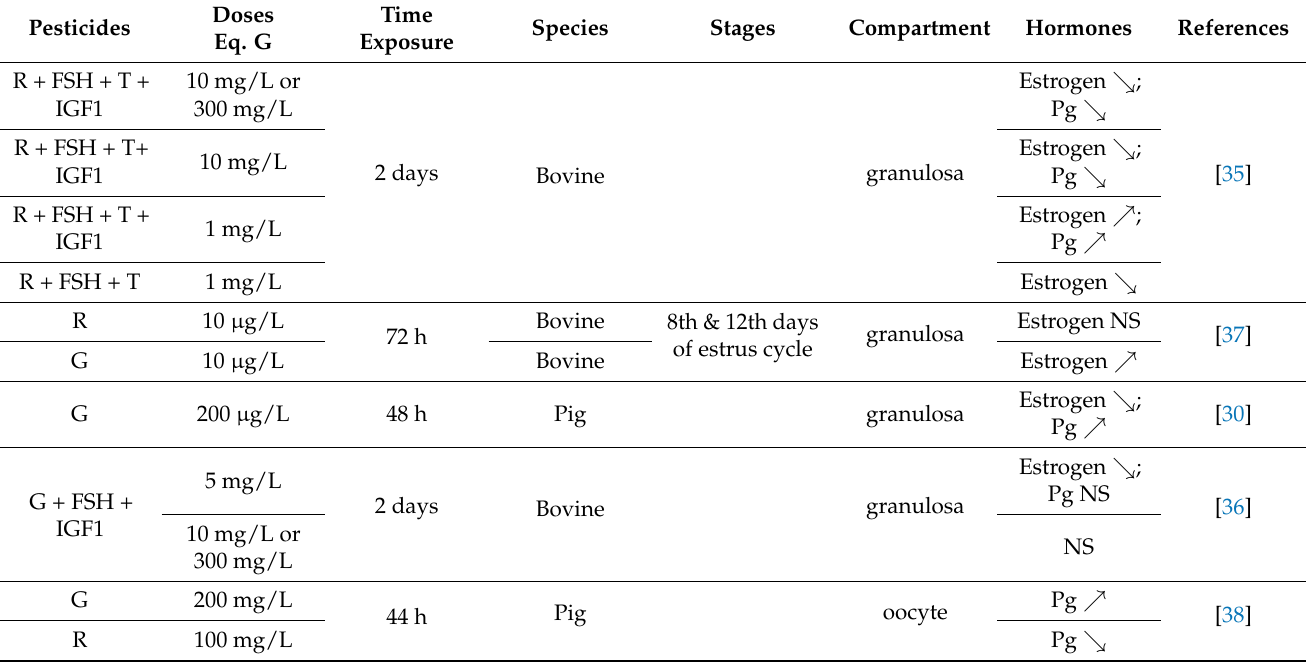
Table 3. Summary of in vitro studies on the impact of G or GBH exposure on steroidogenesis in females. Eq: equivalent. Numbering in brackets indicates